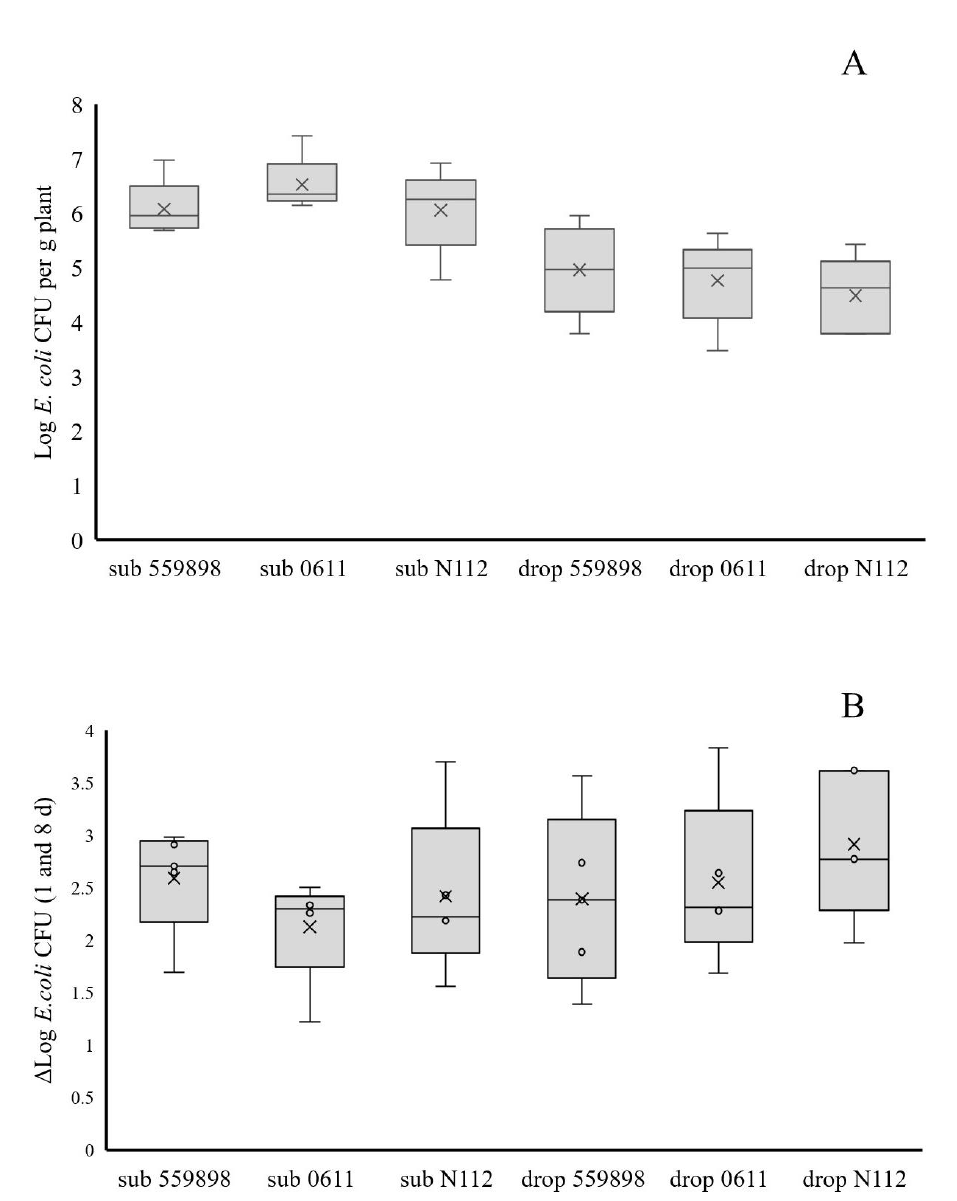
Figure 2. Persistence of three E. coli strains on pea cotyledons after 8 DAS ( A ) and the difference between E. coli colony forming units (CFUs) at 0 DAS on seeds and at eight DAS at the cotyledons, expressed as Δ Log E. coli CFU values ( B ). Cells of three E. coli strains (55989, 0611, N112) were administered to seeds via submergence (sub) or inoculation by placement of 10 µl droplets on the seed surface (drop).